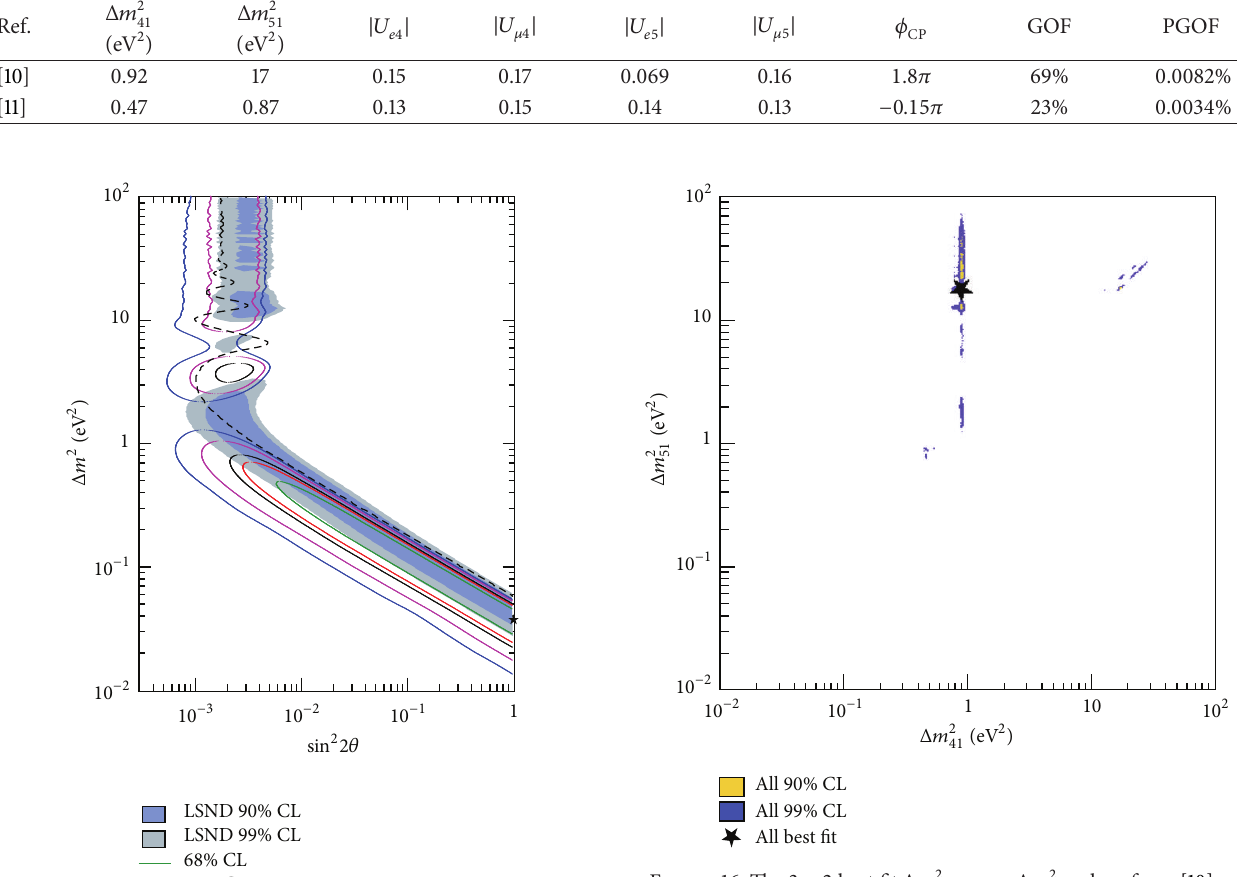
events, which would indicate some other process. Figure 18 shows the MicroBooNE sensitivity to ] 𝜇 → ] 𝑒 oscillations.